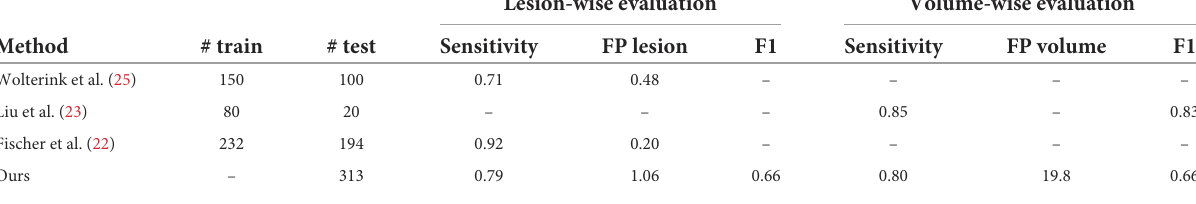
TABLE 3 Comparison with previously published results on automated coronary artery calcium scoring on